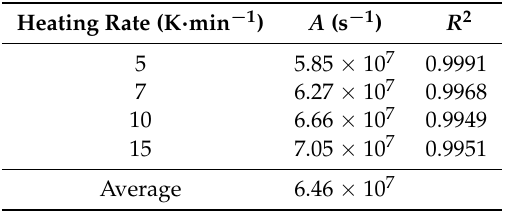
Table 4. Pre-exponential factor calculated for different heating rates.